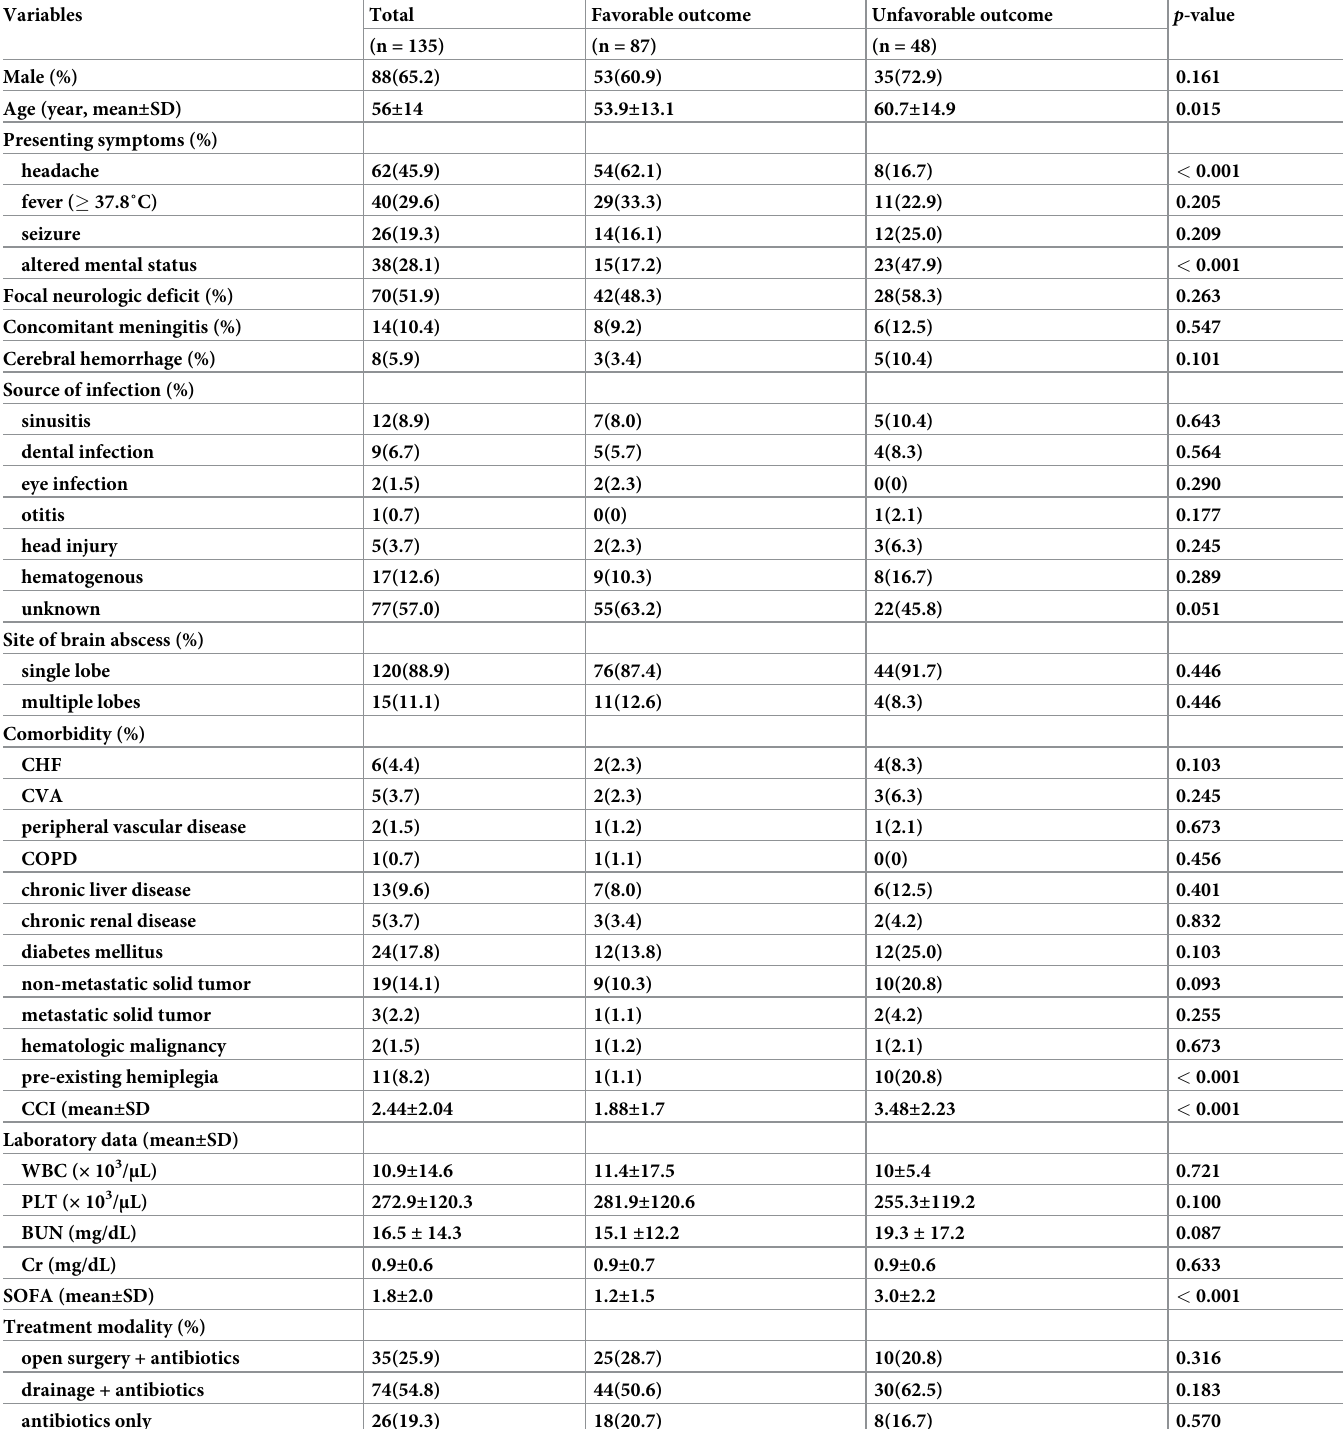
Table 2. Baseline characteristics of the patients with brain